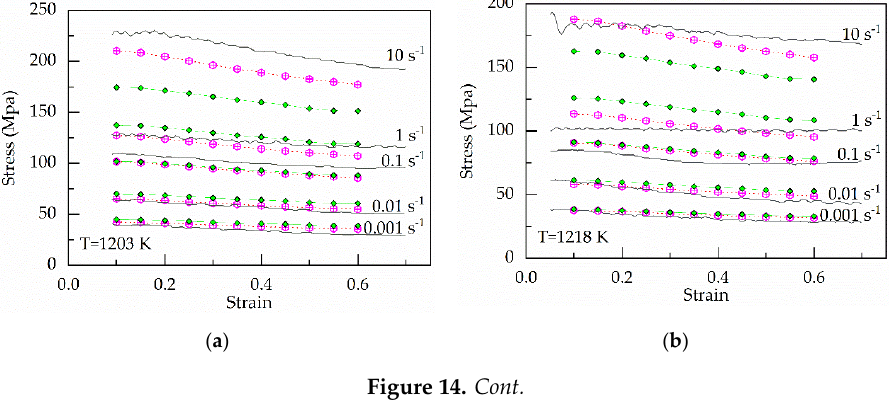
Figure 13. Relation between ln 𝜀̇ ∗ and ln 𝜀̇ in the modified Hensel–Spittel (mHS) equation.